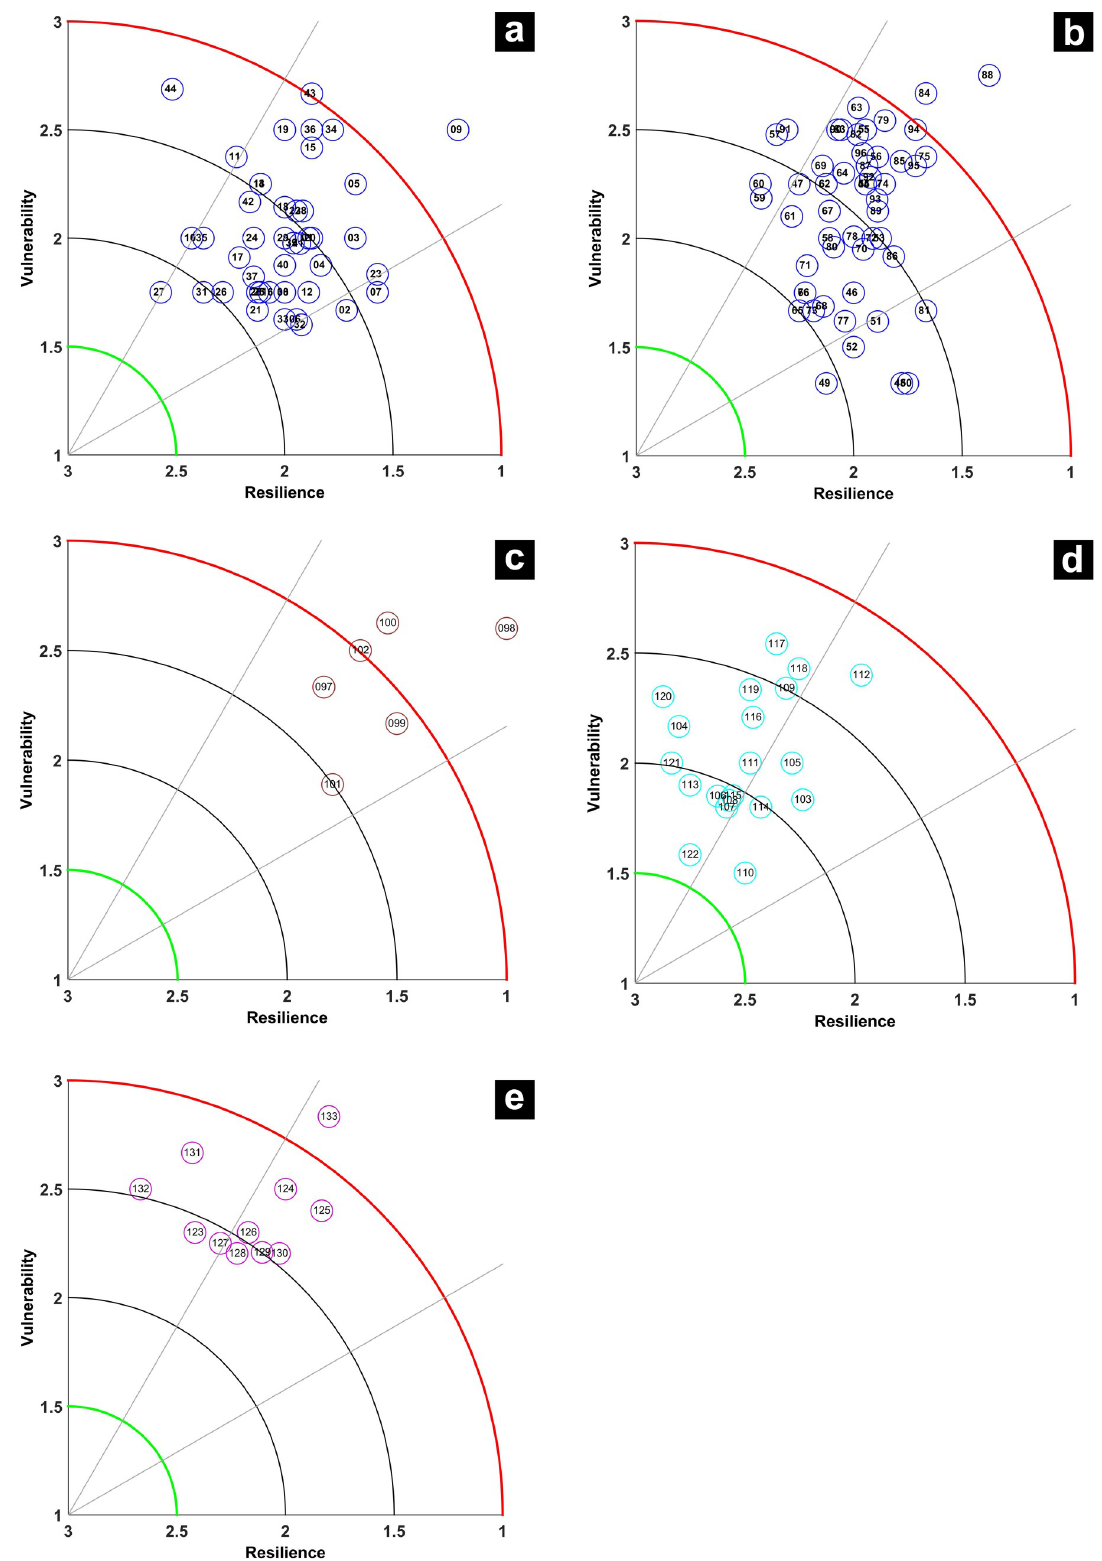
Fig 4. Scatter plot of R-V scores for 44 species of teleosts (a), 52 species of teleosts (b), 6 species of elasmobranchs (c), 20 species of crustaceans (d) and 11 species of molluscs (e). Species identity numbers are as per S2 Table. https://doi.org/10.1371/journal.pone.0255879.g004 PLOS ONE | https://doi.org/10.1371/journal.pone.0255879 August 17,